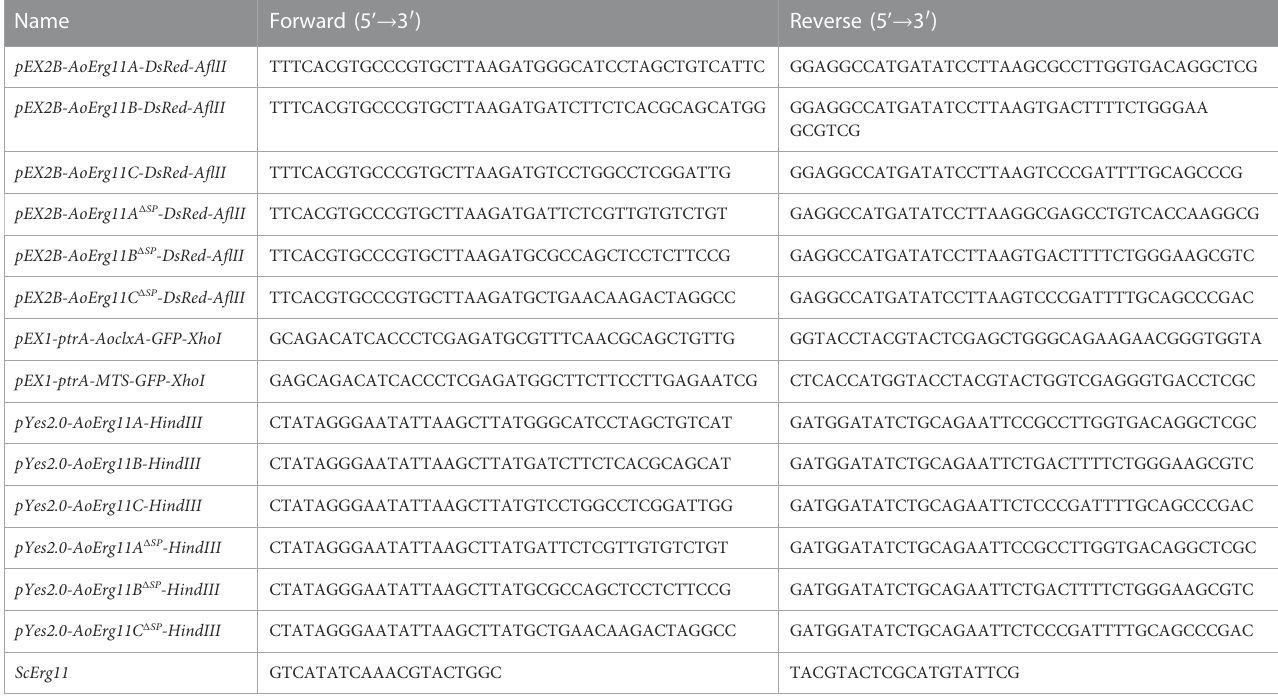
TABLE 4 Primers used for vector construction.